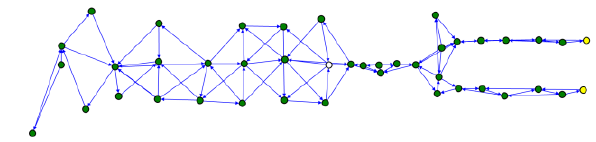
Figure 15. Case Study 2: datum-dependent quality measures after block adjustment.